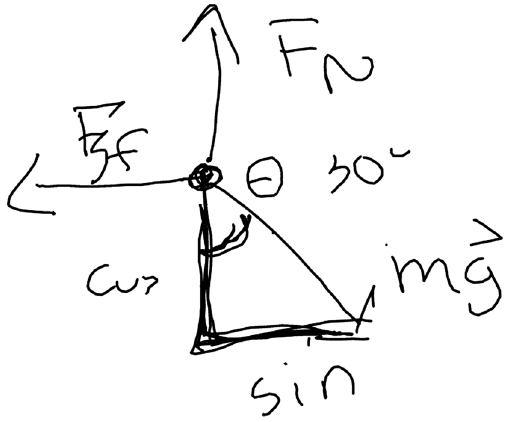
FIG. 6. Student A ’ s FBD for the friction